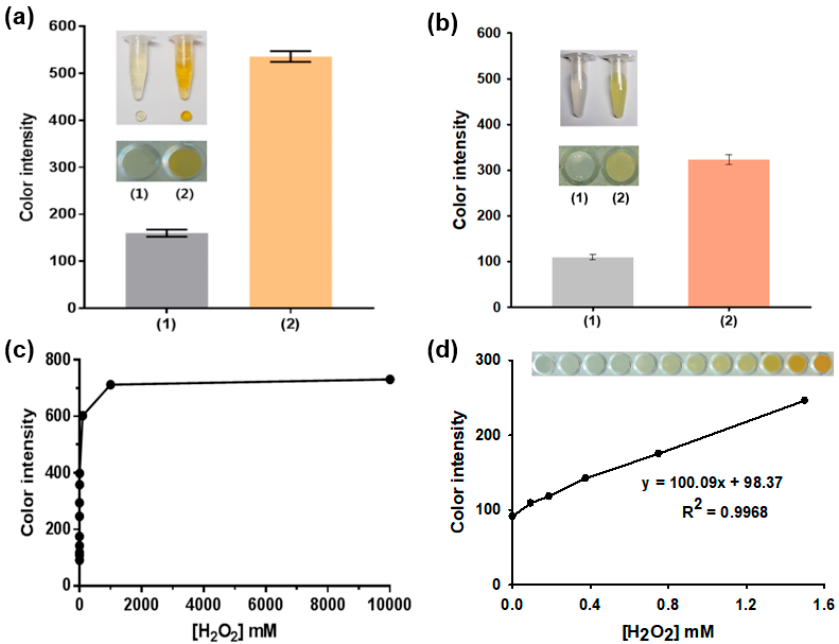
Figure 4. Colorimetric detection of H 2 O 2 using agarose_nanoceria composite. Real images of the color-change reaction in the (1) absence and (2) presence of H 2 O 2 (10 mM) and the corresponding